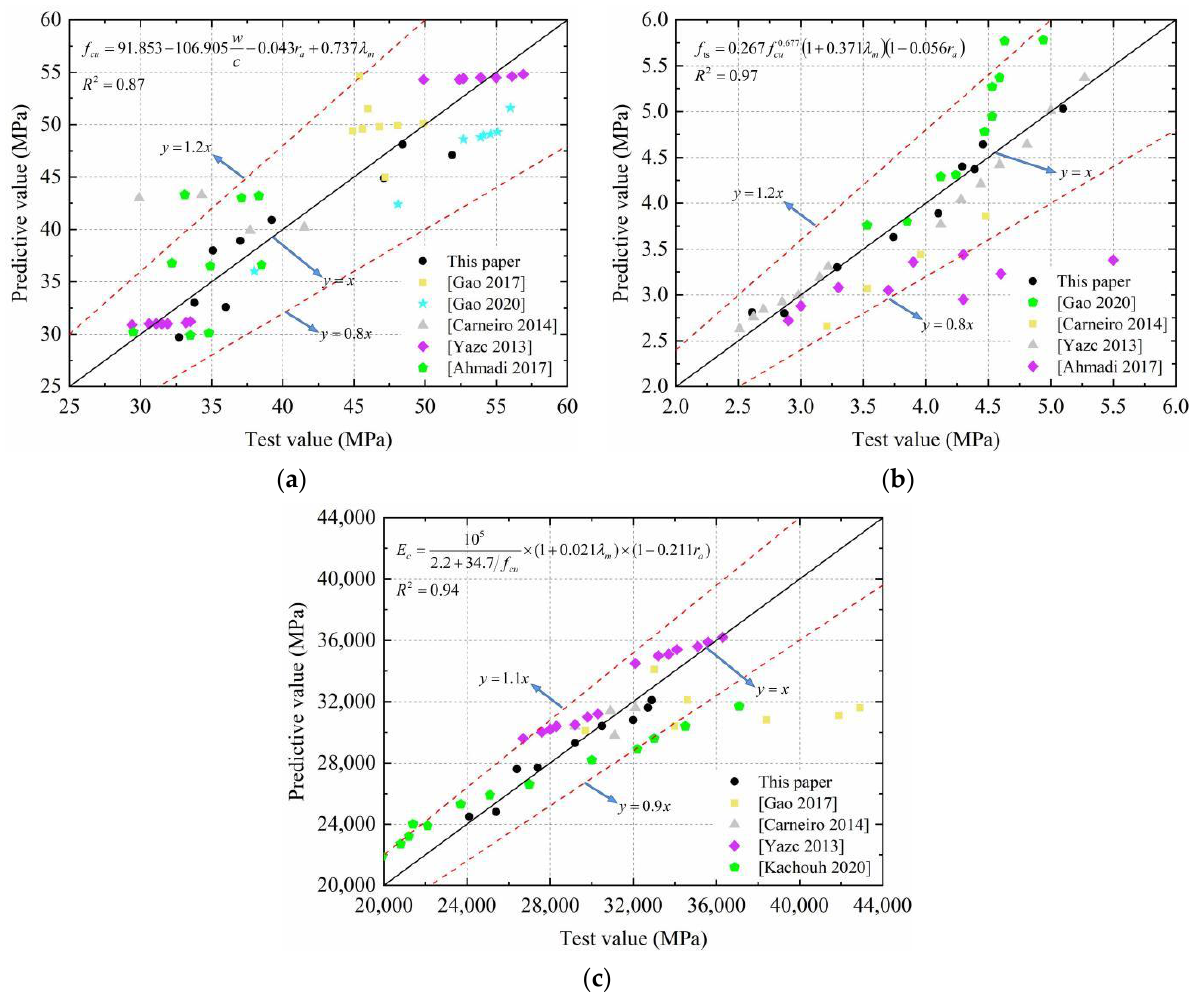
Figure 14. Accuracy of prediction model for mechanical properties of SFRRC: ( a ) Compressive strength; ( b ) Splitting tensile strength; ( c ) Elastic modulus. Table 7. Experimental data and information about prediction.